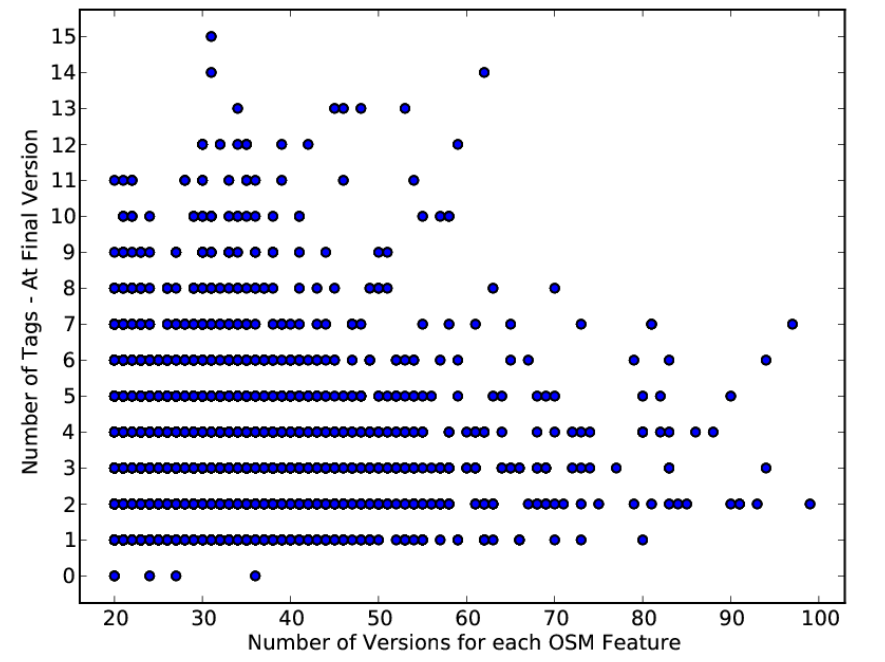
Figure 6. Scatter plot of the number of tags against the number of versions (final) for all objects in the case study